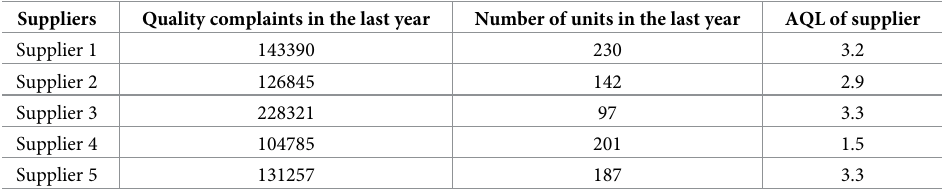
Table 8. Quality complaints, number of units sold, and aql of each